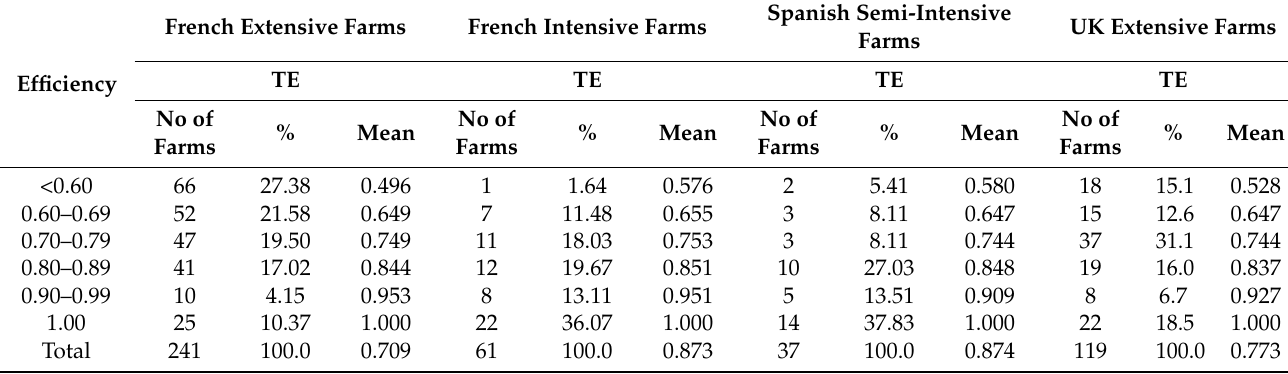
Table 1. Frequency distribution of farms by technical efficiency (TE) estimates from the DEA model.